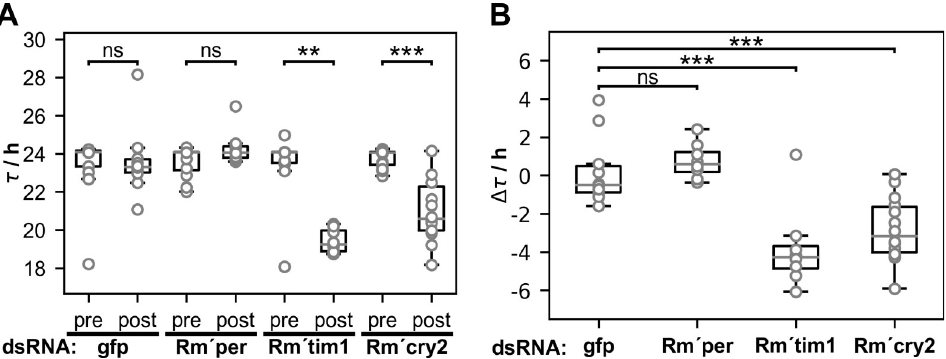
Fig 7. In running wheel assays Rm´tim1 and Rm´cry2 dsRNA injections, but not injections of Rm´per dsRNA significantly shortened the period ( τ ) of locomotor activity. ( A )Comparison of period before and after injections of gfp- (n = 10; p = 0.7108), Rm´per (n = 8; p = 0.0546), Rm´tim1 - (n = 8; p = 0.0016), or Rm´cry2 dsRNA (n = 14; p < 0.0001). Periods of dsRNA injected animals were measured 2–4 weeks after injection and compared to one week before the injection. After injections of Rm´per dsRNA cockroaches showed unchanged locomotor activity rhythms with only a tendency to develop longer periods, while both other injections shortened activity rhythms. ( B )Comparison of the difference in periods of locomotor activity rhythms before and after injections ( Δ τ ) between gfp controls (n = 10) and Rm´per (n = 8; p = 0.4579), Rm´tim1 - (n = 8; p = 0.0005), or Rm´cry2 dsRNA injected cockroaches (n = 14; p = 0.0003). Periods were determined using chi-square periodogram analysis. Student‘s t-tests were used to determine significant differences between animals of one group before and after the injection ( A ) and between Δ τ of gfp control, the Rm’per , the Rm´tim1 , and Rm´cry2 dsRNA injected animals ( B ). ns: not significant; �� : p < 0.01; ��� : p <